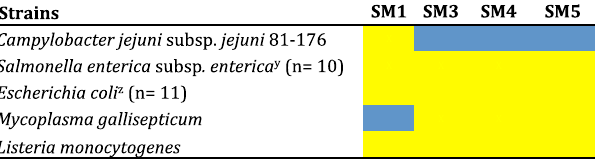
Figure 1. Activity spectrum of the selected four small molecule (SMs) at 200 μ M on several foodborne and avian pathogens. Yellow cells: cidal effect; blue cells: bacterial growth observed; x Salmonella enterica serotypes (Typhimurium, Albany, Anatum, Braenderup, Enteritidis, Heidelberg, Javiana, Muenchen, Newport, and Saint-Paul); z avian pathogenic E. coli O1, O2, O8, O15, O18, O35, O78, O109, and O115 serotypes, and